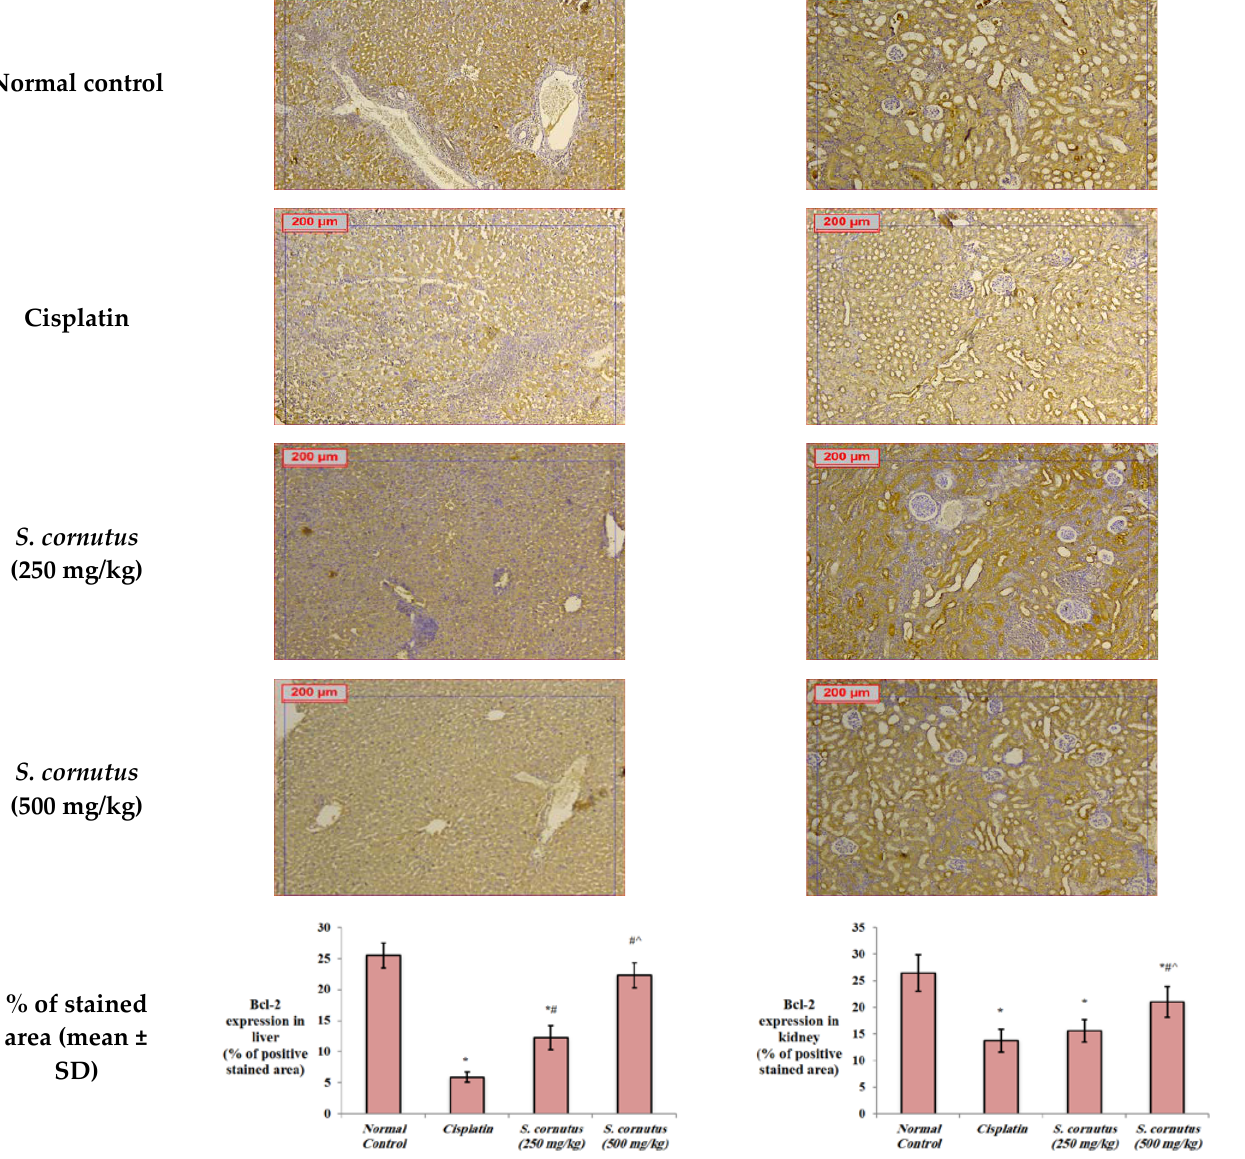
Figure 6. The effect of S. cornutus crude extract on the expression levels of Bcl-2 determined by immunohistochemistry in the ( A ) liver and ( B ) kidney tissues of the experimental mice. Data of the percentage of positive stained area are expressed as mean ± SD and analyzed using one-way ANOVA followed by Bonferroni’s post hoc test ( n = 8). * significantly different vs. the normal control group; # significantly different vs. the cisplatin group; ^ significantly different vs. the S. cornutus (250 mg/kg) group. Differences were considered significant at p < 0.05.